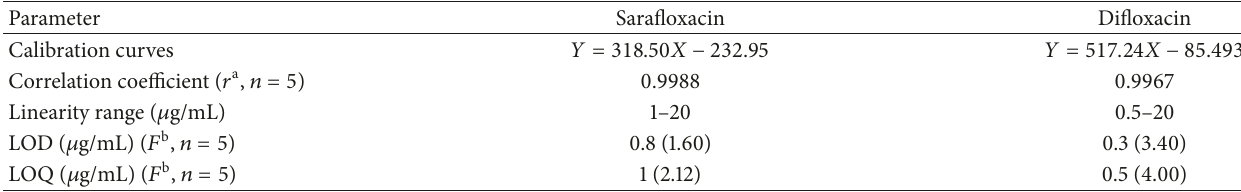
Table 3: Analytical parameters of the current method.